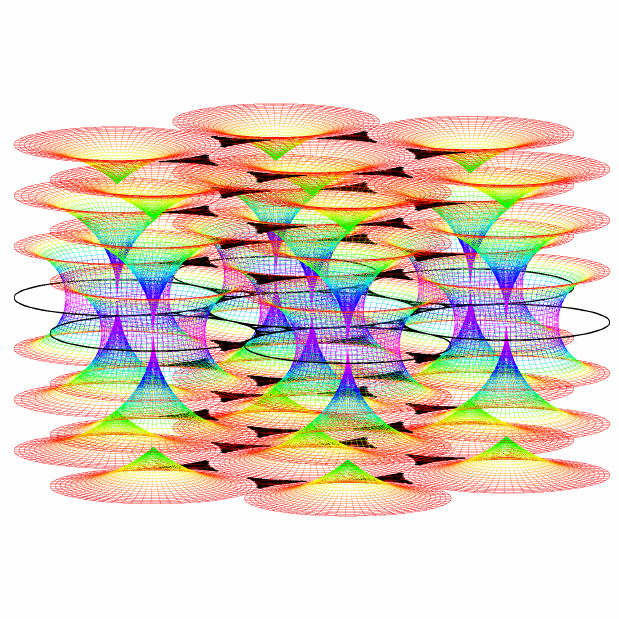
Figure 12. simulation of the smectic layers for three values of µ ( µ = 1 ; µ = 2 ; µ = 3 ) corresponding to layers of type 3 with two sheets; R = 0 . 9 , θ = 80 ◦ , ϕ = 10 ◦ .